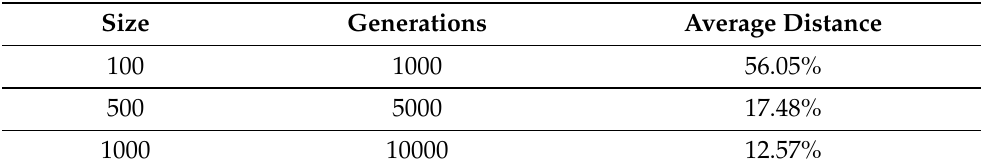
Table 5. Crossover domination experiment—averaged results from all examples, grouped by popula- tion sizes and iterations count.